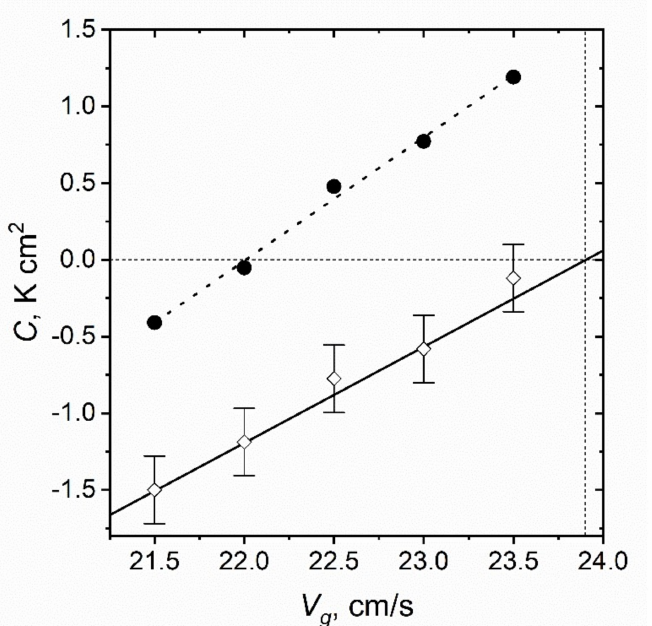
Figure 4. Determination of laminar burning velocity for a flame at φ = 0.75, exposed to pulsed microwaves with a pulse duration of 50 µ s and a frequency of 1 kHz at an electric field of E RMS = 350 kV/m. Open symbols and solid line represent the data with microwaves and filled symbols and dotted line represent the corresponding flame without microwave